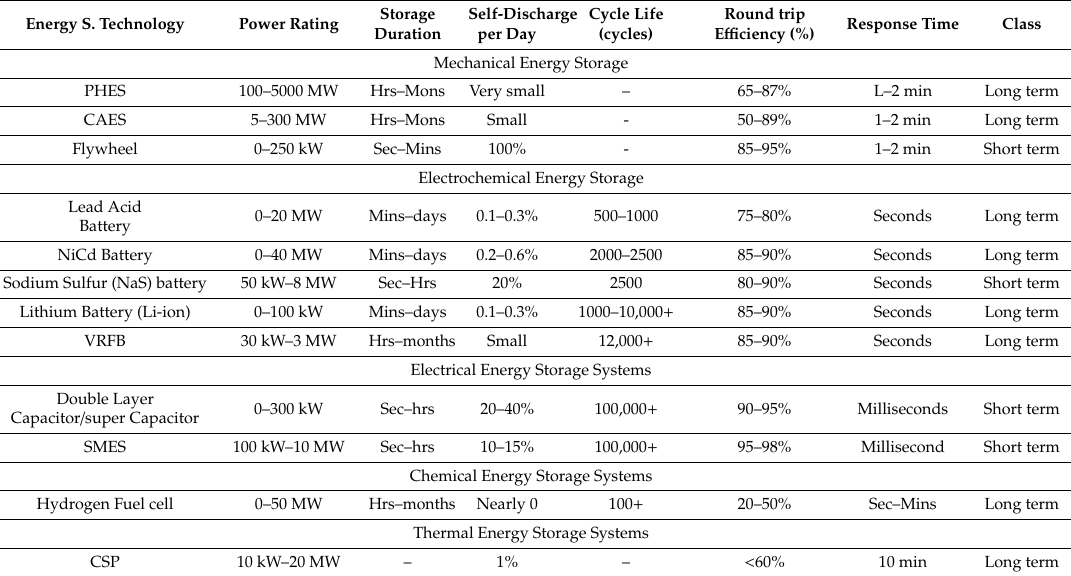
Table 8. Associative characteristics of energy storage technologies